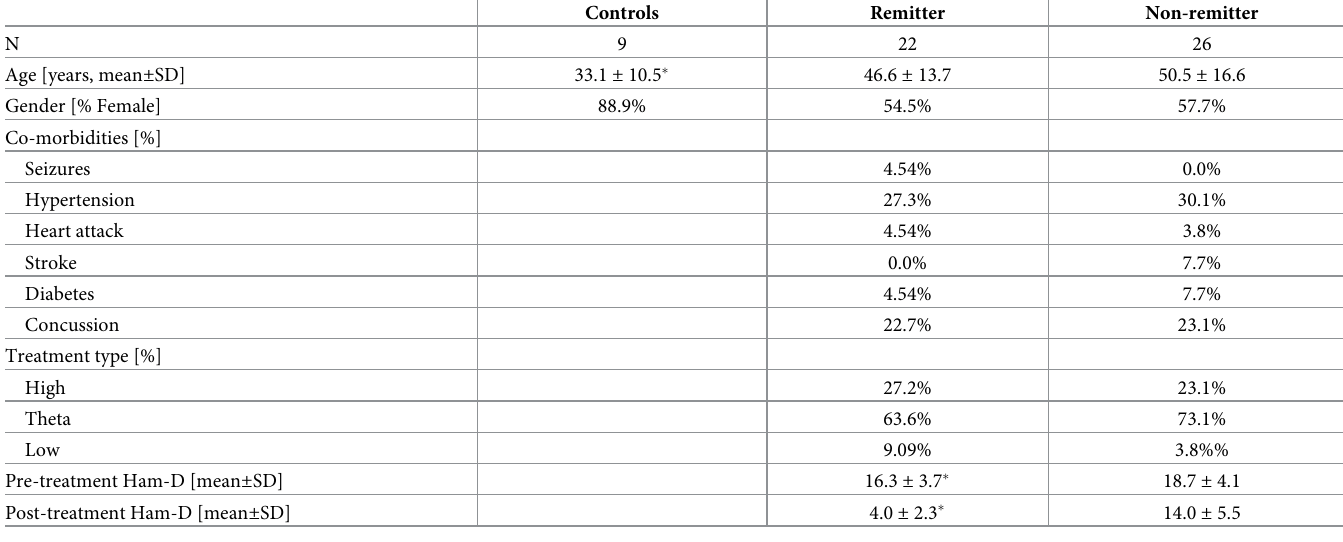
Table 1. Demographics and clinical information of all subjects separated by remitter/non-remitter status and controls.